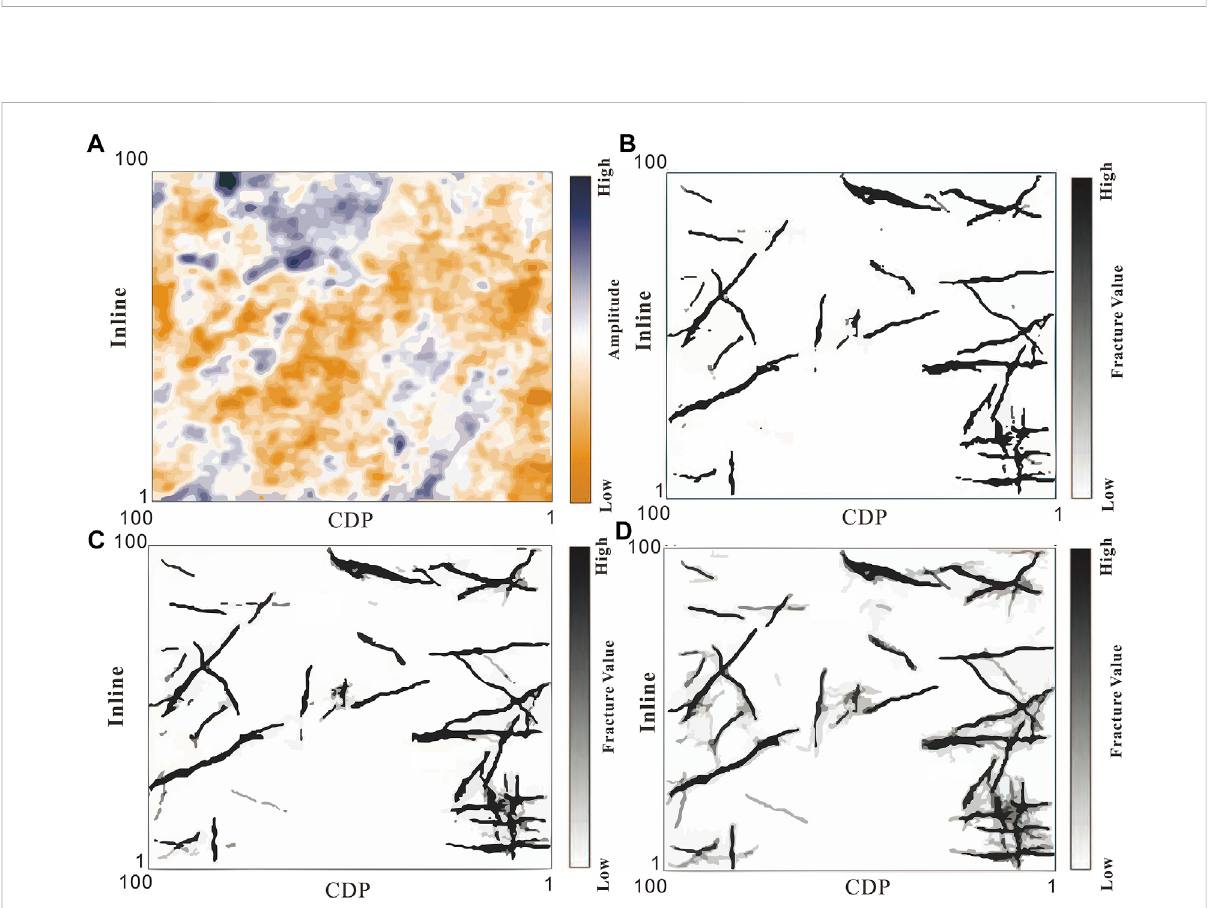
FIGURE 7 Ant slice along the layer (A) Amplitude slice along the layer (B) Full-band ant slice along the layer. (C) 30 Hz ant slice along the layer. (D) 60 Hz ant slice along the